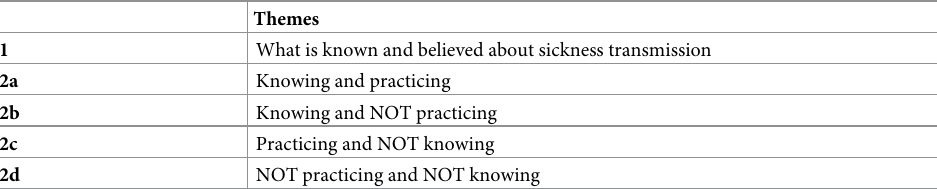
Table 1. Themes emerging from data